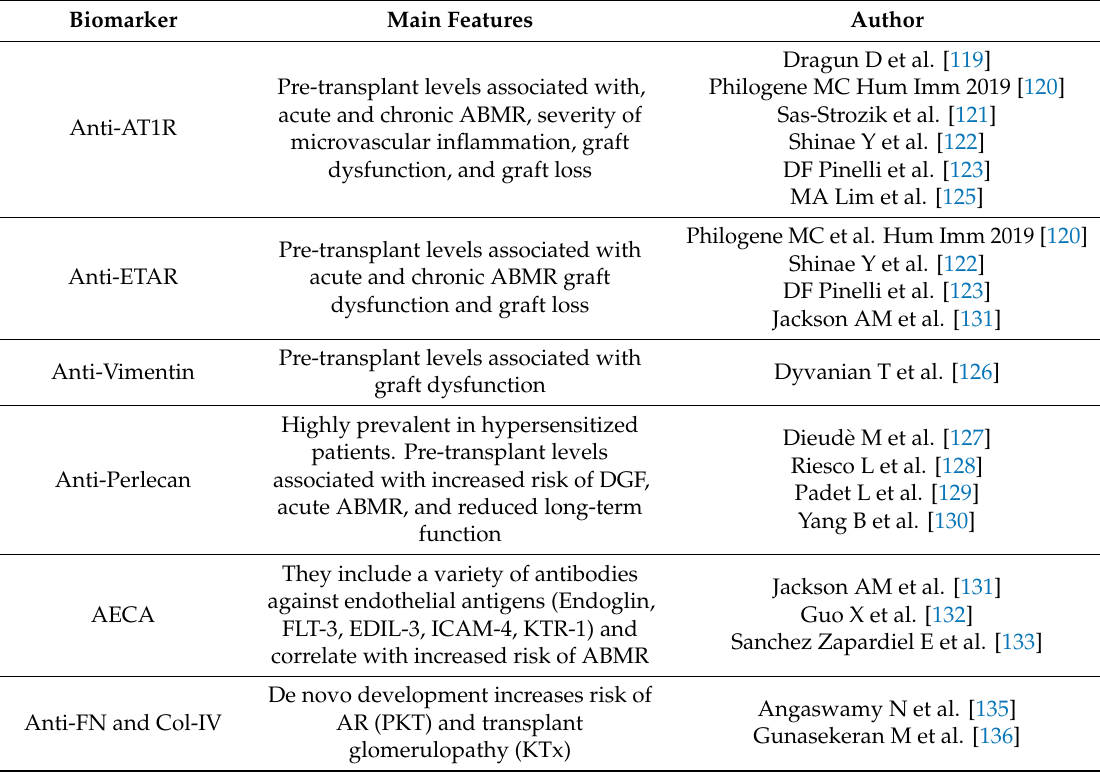
Table 5. Non-HLA DSA as a potential biomarker for antibody-mediated rejection (ABMR).